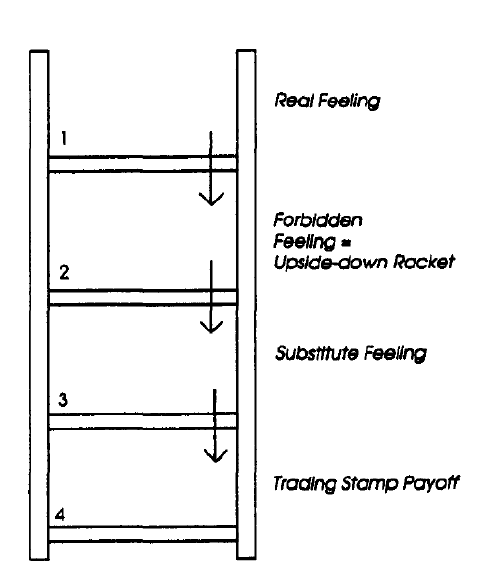
Figure 8: Upside-Down Racket Ladder (Summerton, 1995, p.219) states, transactions, games and scripts. Summerton suggested we should add relationship analysis and the analysis of